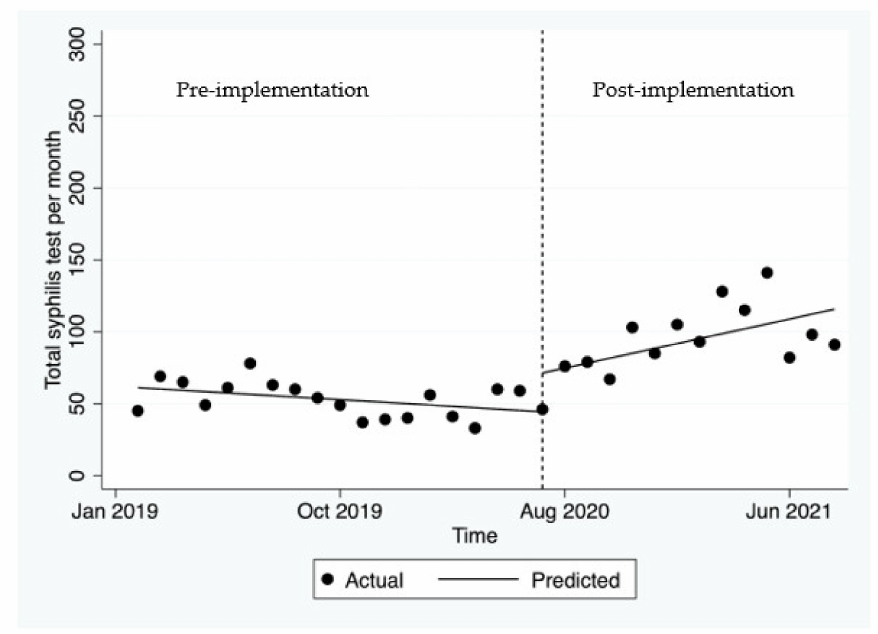
Figure 3. Number of tests for syphilis before and after the hub-and-spoke model was